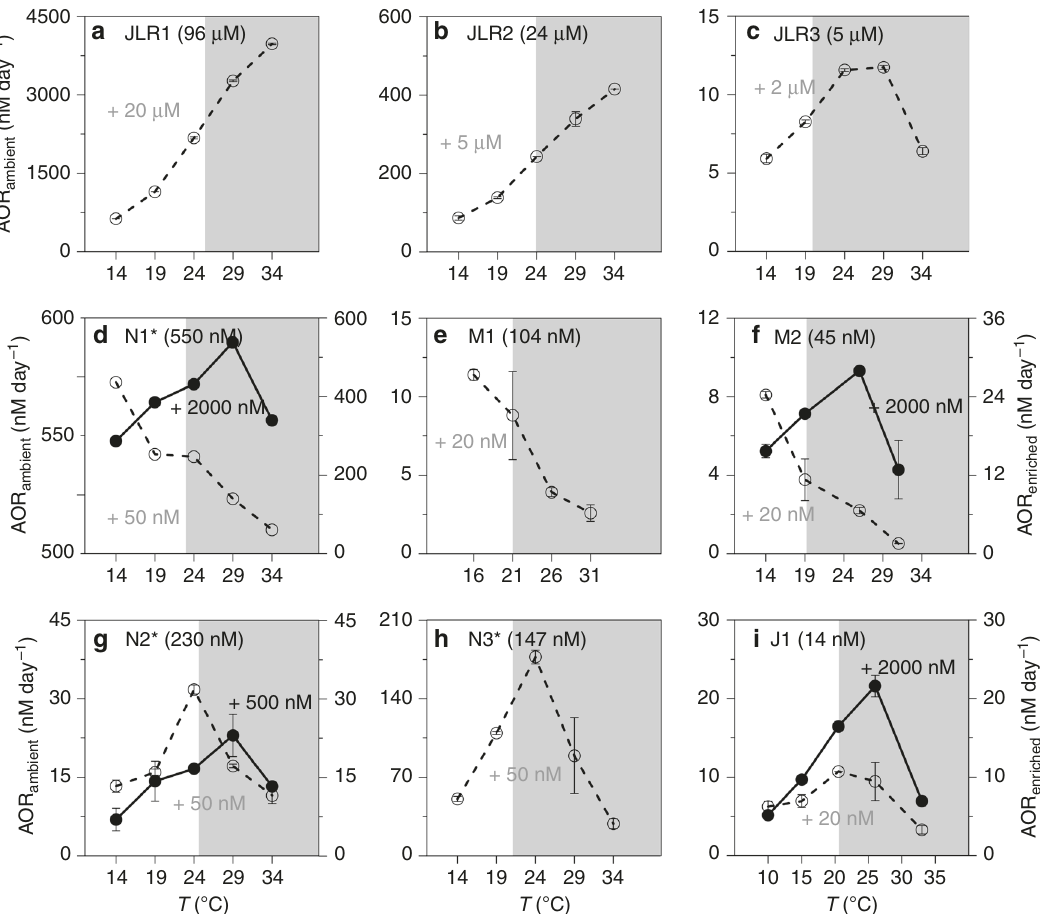
Fig. 1 Thermal responses of ammonia oxidation rates. In situ substrate concentrations are given in parentheses. Ammonia oxidation rates near the ambient substrate level (AOR ambient ) are shown as open circles with dashed lines and at the enriched substrate level (AOR enriched ) as solid circles with solid lines. The tracer concentrations of 15 NH 4 + added for the ambient and enriched incubations are shown in gray and black numbers, respectively. Gray area denotes temperatures higher than the in situ temperature. The station IDs with asterisk (*) refer to the stations at which the ammonium concentrations were measured in the shore-based laboratory several days after collection. The rate data are mean values, instead of standard deviation the given bars indicate the variation range of two independent experiments, except N1 station ( n =